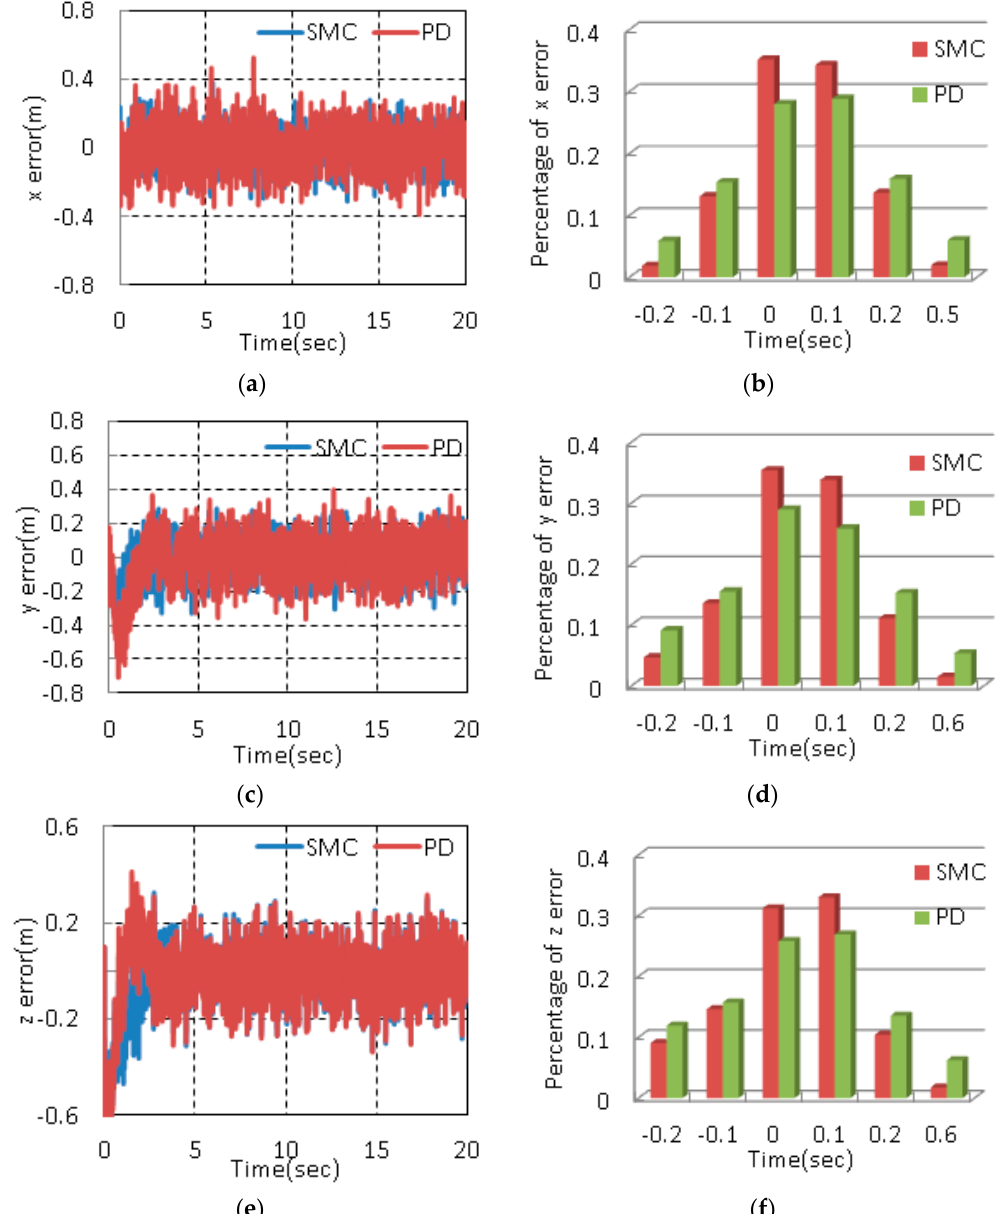
Figure 14. Position errors and histograms of position errors in Case 2 ( a ) x position error; ( b ) Percentage of x position error; ( c ) y position error; ( d ) Percentage of y position error; ( e ) z position error; ( f ) Percentage of position error. Table 7. Comparison of experimental results under two cases .